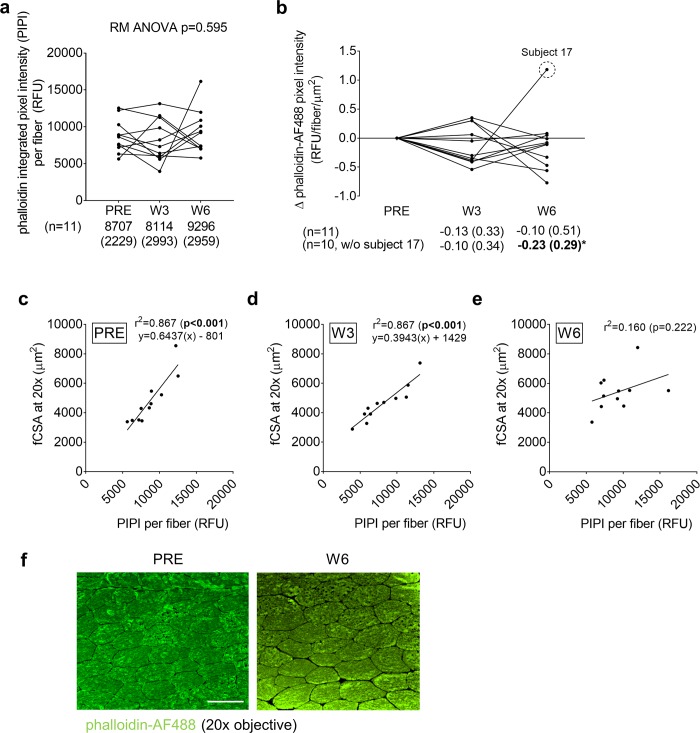
PRE, W3, and W6 VL biopsy contractile protein per muscle fiber assessed through phalloidin-AF488 staining.All line graph data show individual responses with mean ± standard deviation (SD) values below each time point. Phalloidin-AF488 integrated pixel intensity (PIPI) per fiber represents the amount of actin per fiber where increases in this metric suggest increases in the amount of actin per muscle fiber. This metric was not significantly altered throughout the intervention (panel a). Phalloidin pixel intensity per fiber per μm2, which represents actin content corrected for fCSA, demonstrated numerical but non-significant decreases from PRE to W3 and W6 (panel b), although the removal of subject 17 (statistical outlier) indicated a significant decrease occurred from PRE to W6. Panels c and d demonstrate a tight coupling at PRE and W3 between fCSA and contractile protein content per fiber. However, only a modest and non-significant correlation was observed at W6 (panel e). Panel g illustrates PRE and W6 phalloidin-AF488 stain 20× images from one subject (scale bar = 100 μm).